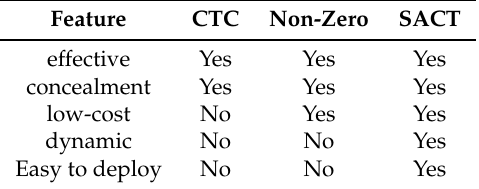
Table 3. Comparison of features of different anonymous communication